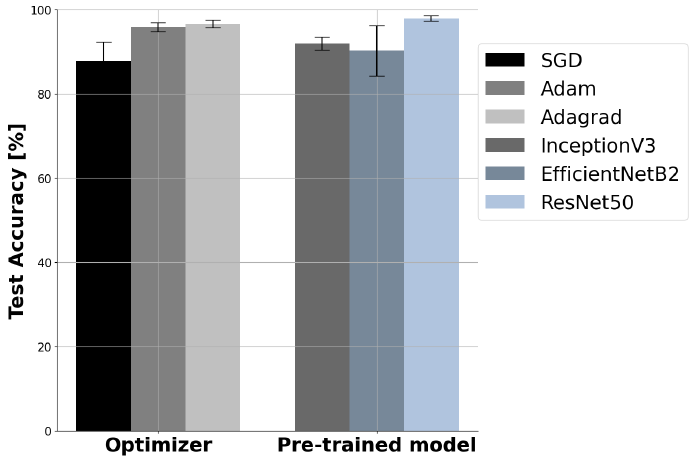
Figure 5. ( Left ) The effect of optimizer choice on the performance of multistage transfer learning. ( Right ) The effect of CNN model choice on the performance of multistage transfer learning. SGD: stochastic gradient descent.